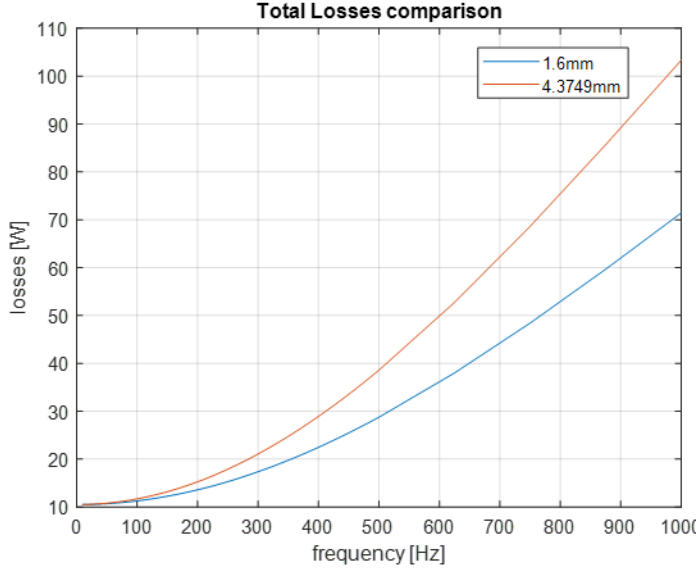
Figure 21. Slot opening total losses comparison, hps = 4 mm.